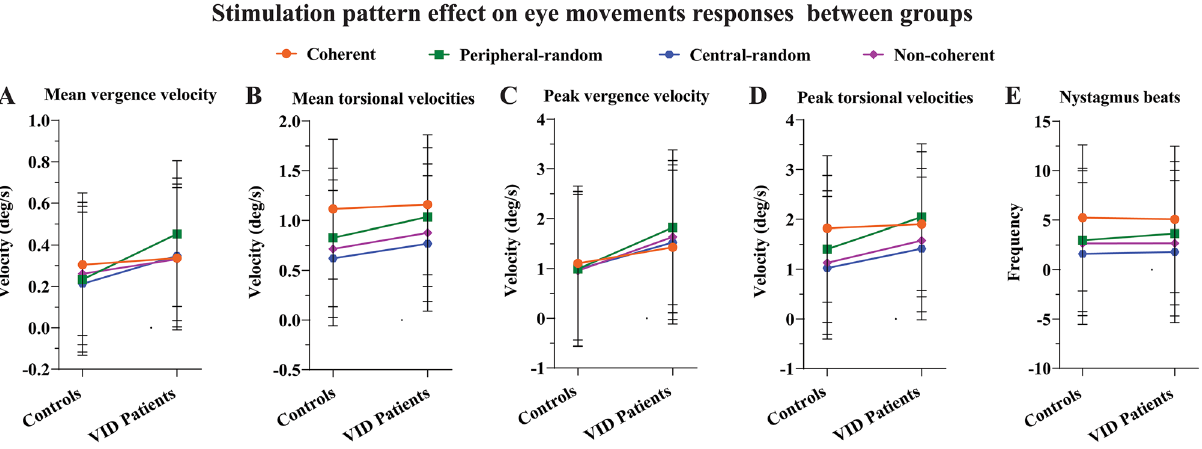
Figure 4. ( A ) Interval plot illustrating the modulating effect of different optokinetic stimulation patterns over the mean vergence slow-phase velocities ( A ), mean torsional velocities ( B ), peak vergence velocities ( C ), and peak torsional velocities ( D ) in degrees per second, as well as the number of nystagmus beats ( E ), illustrated with the 95% confidence interval (error bars) between healthy individuals and concussed individuals with VID.